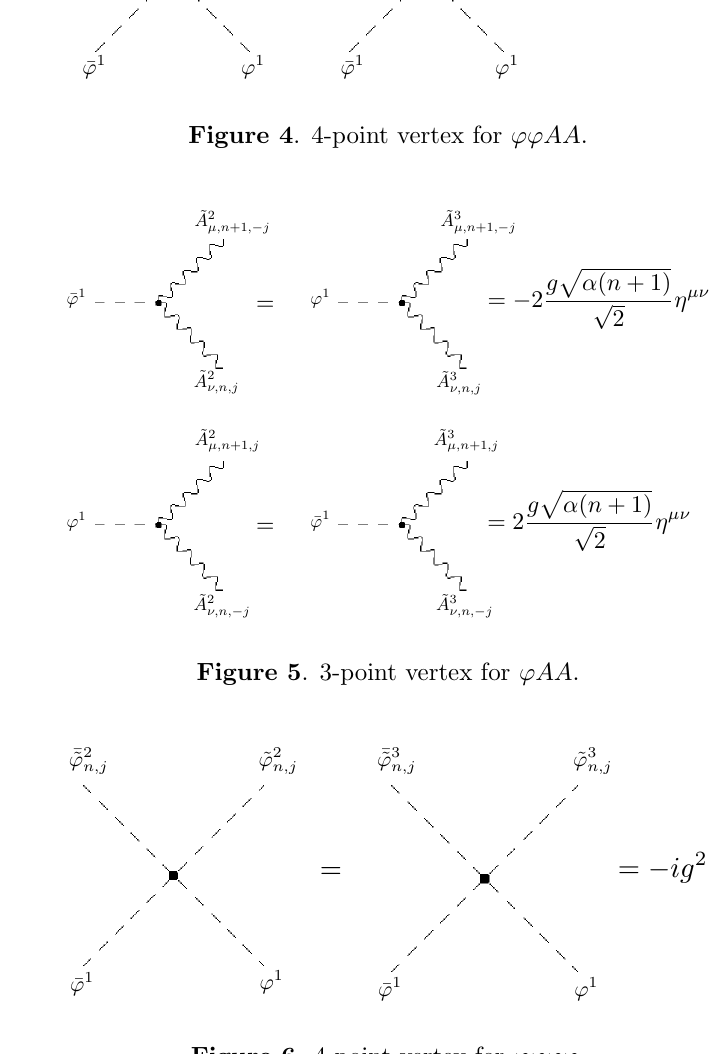
Figure 6 . 4-point vertex for ϕϕϕϕ